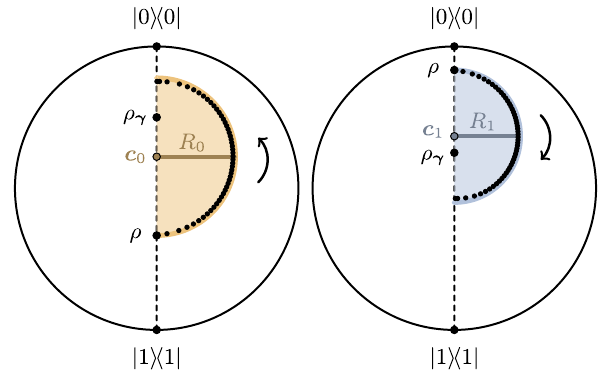
FIG. 8. Qubit memoryless accessibility region. We show the Q e L i (black dots) as described in the initial state ρ evolved by i main text. The evolved states clearly approach the extremal paths for thermodynamic processes with memory given by circles ð c 0 ; R 0 Þ and ð c 1 ; R 1 Þ . In both panels, Δ is chosen such that the evolution is divided into 100 equal steps (to increase readability, only the even steps are plotted). (a) Parameters: x ¼ 0 , z ¼ − 1 = 3 and ζ ¼ 1 = 2 . (b) Parameters: x ¼ 0 , z ¼ 5 = 6 , ζ ¼ 1 = 4